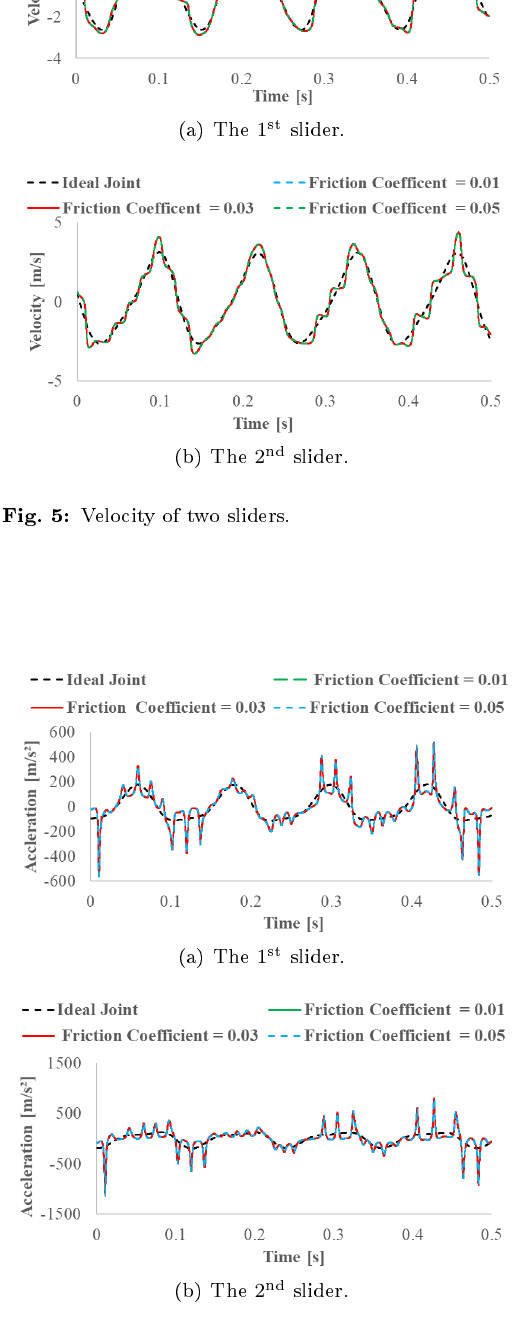
Fig. 6: Acceleration of two